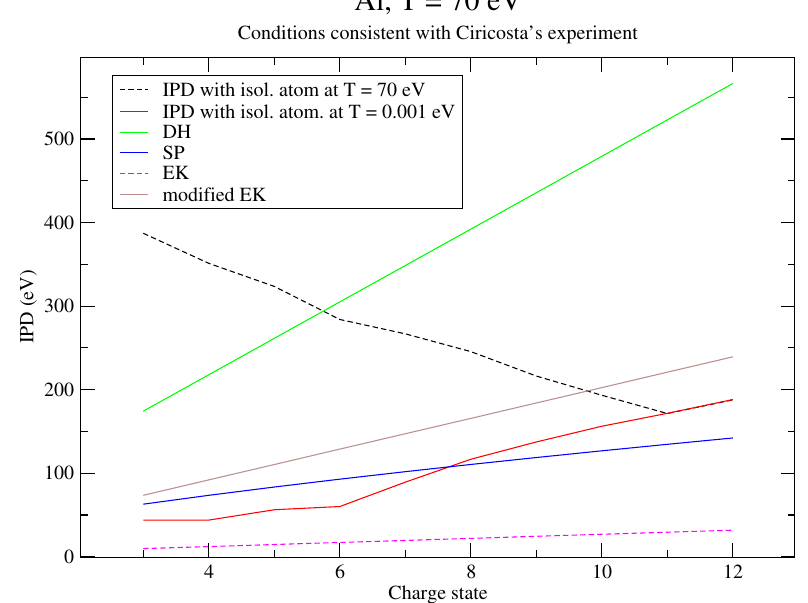
Figure 2. Same as Figure 1 but with a plasma temperature of T = 70